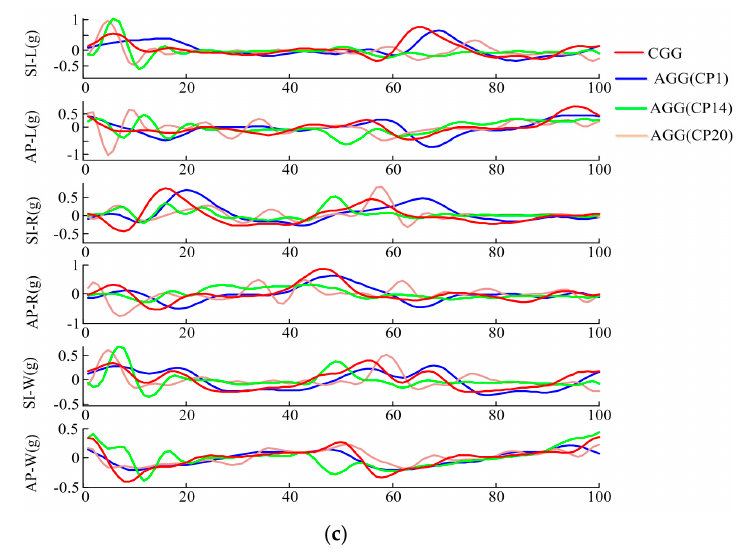
Figure 6. Comparisons between CGG and: ( a ) AGGs of AD group; ( b ) AGGs of TD group; ( c ) AGGs of three children with CP.